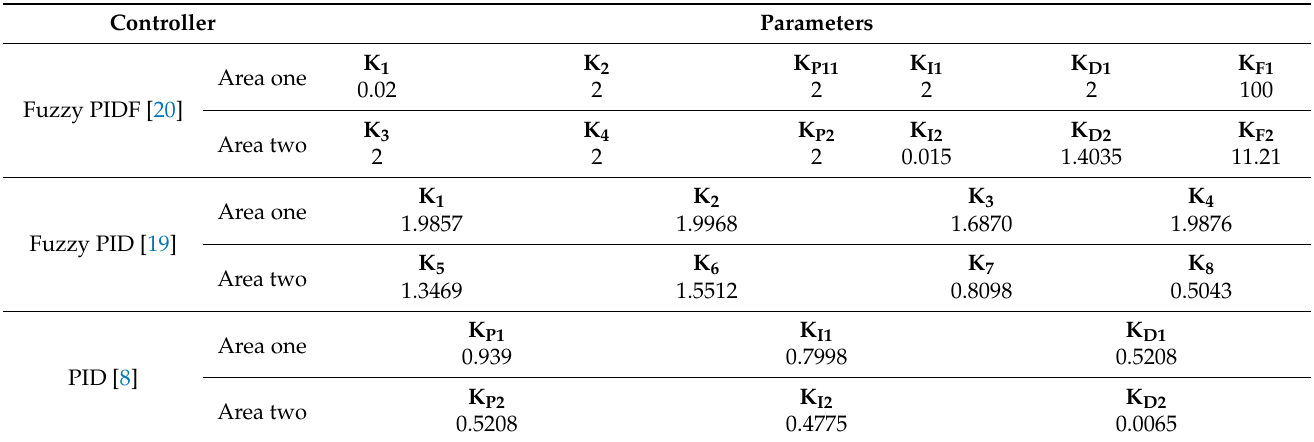
Table 4. Optimal gains of FC FOPI-FOPD obtained by